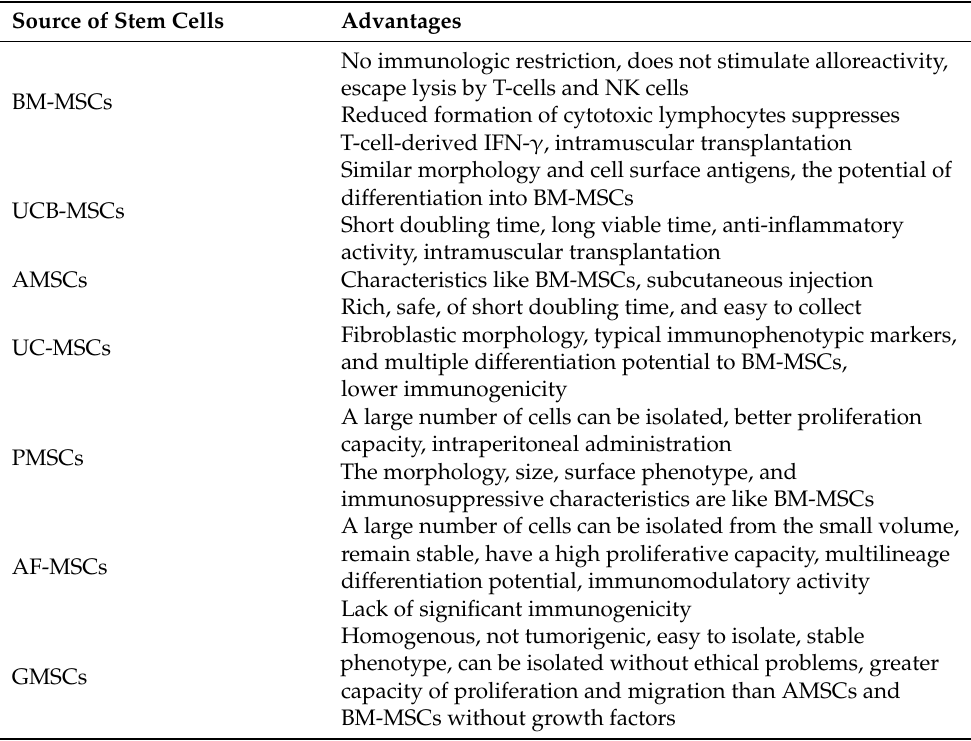
Table 1. Advantages and limitations of the stem cells enhancing healing in DFUs. Stem cells showed improved clinical efficacy in enhancing wound healing in DFUs by increased angiogenesis and re-epithelialization [17]. The common side effects associated with stem cell therapy are whole body urticaria, diarrhea, oral ulceration, the elevation of serum creatinine level, number, and differen- tiated potential decline with aging, nausea, and vomiting. Bone marrow-mesenchymal stem cells (BM-MSCs), umbilical cord blood-derived mesenchymal stem cells (UCB-MSCs), adipose-derived mesenchymal stem cells (AMSCs), umbilical cord-derived mesenchymal stem cells (UC-MSCs), placenta-derived mesenchymal stem cells (PMSCs), and human amniotic fluid-derived stem cells (AF-MSCs), human gingiva-derived mesenchymal stem cells